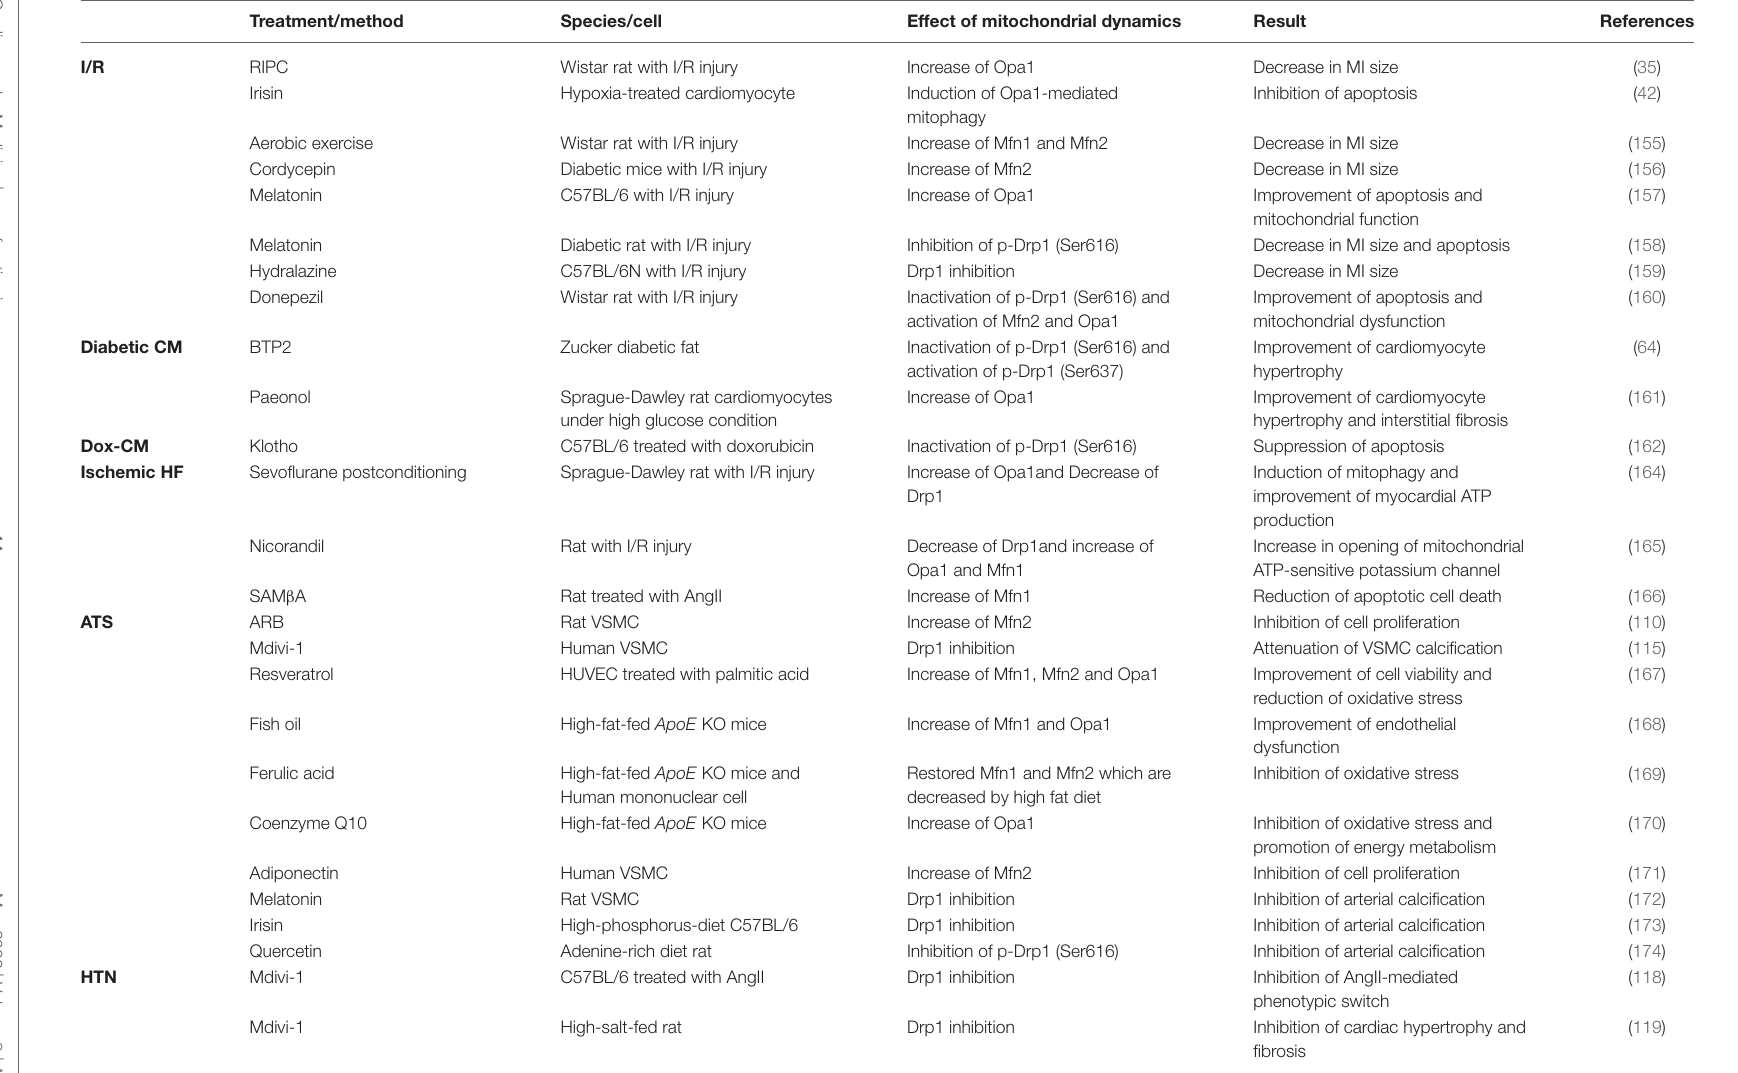
TABLE 2 | Treatments of CVDs through regulation of mitochondrial